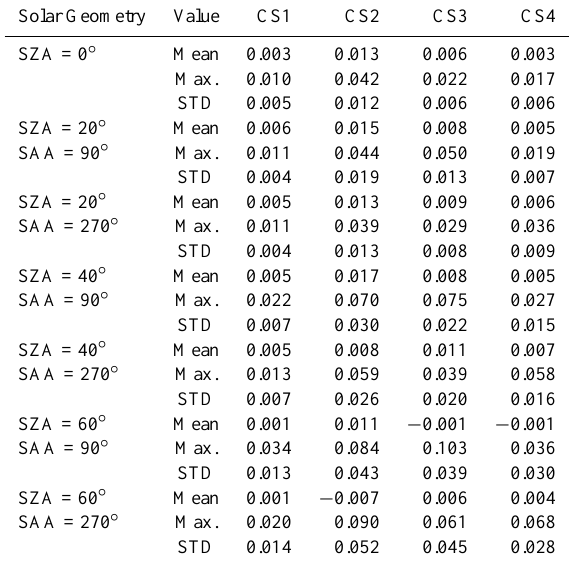
Table 2. Mean, maximum (Max.), and standard deviation (STD) of ICA biases for CS1, CS2, CS3, and CS4 after averaging 50 pixels ( ∼